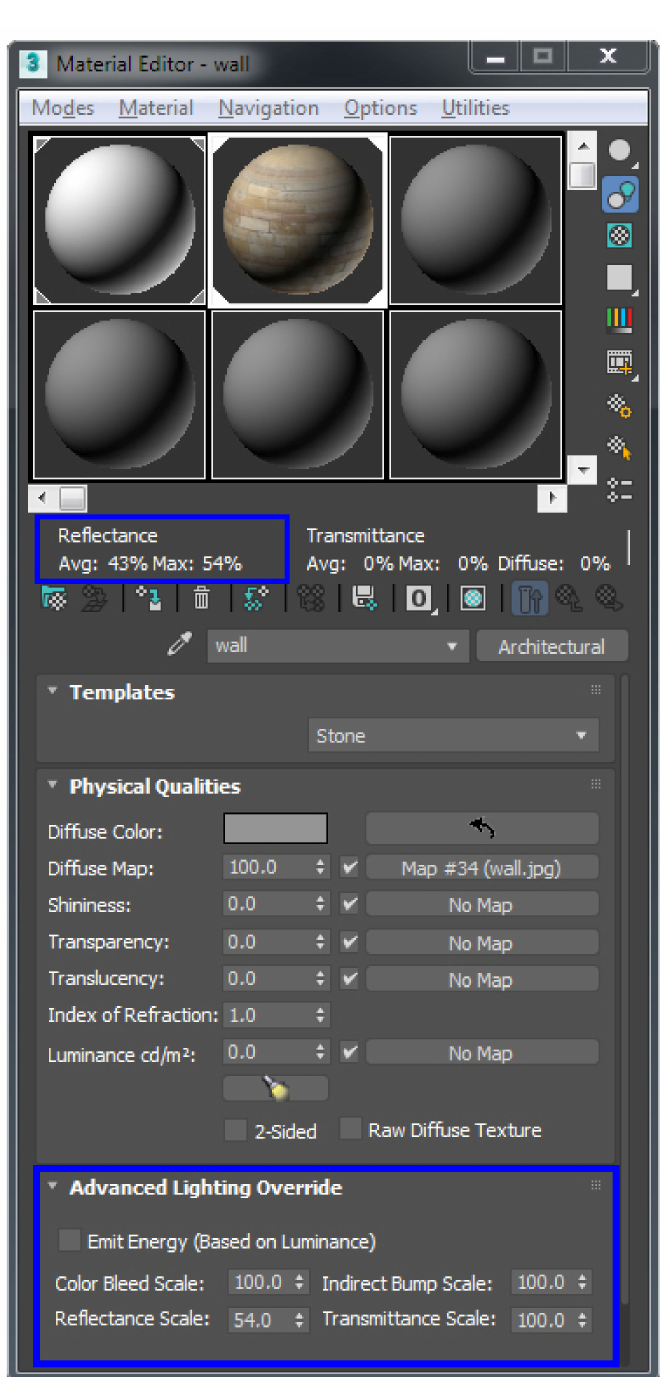
Figure 14. Reflectance correction by means of reflectance scale parameters under Autodesk 3ds Max